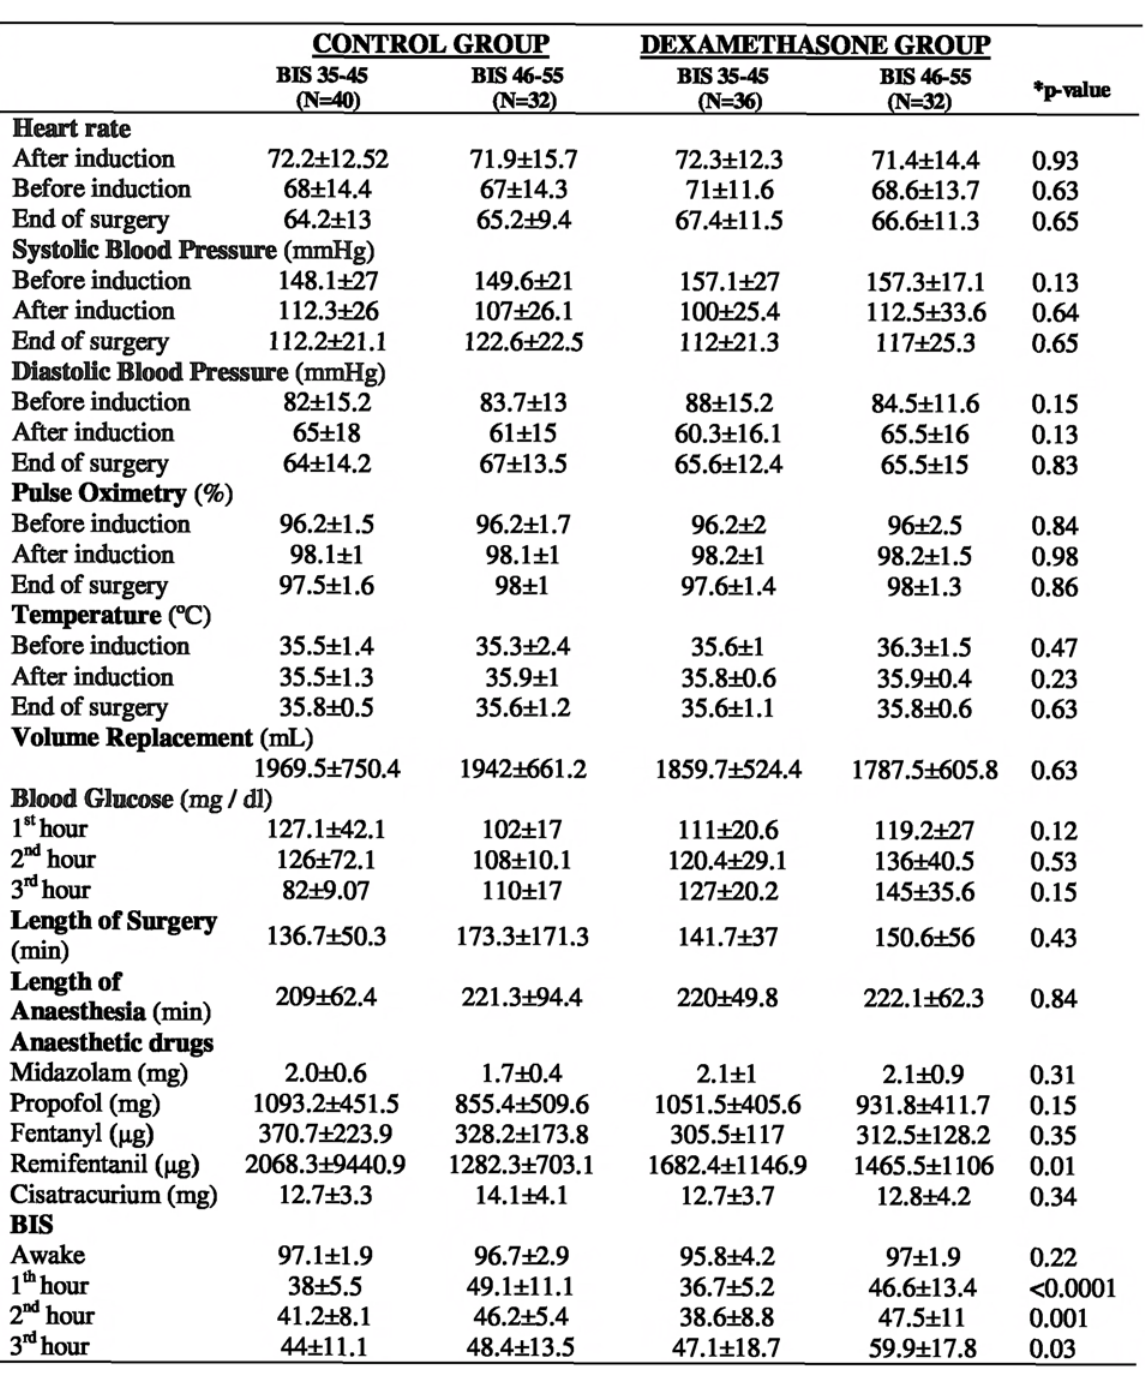
Fig 4. Intraoperative data. Data are mean ± SD; BIS: bispectral index; * p -value for the Generalized Estimating Equations (GEE).